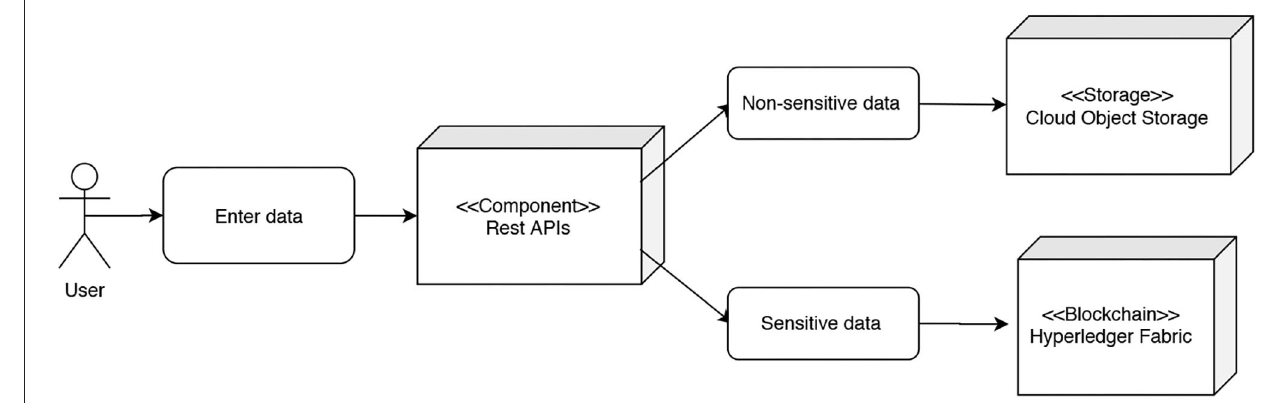
FIGURE 4 | Standard flow of transactions within the network.